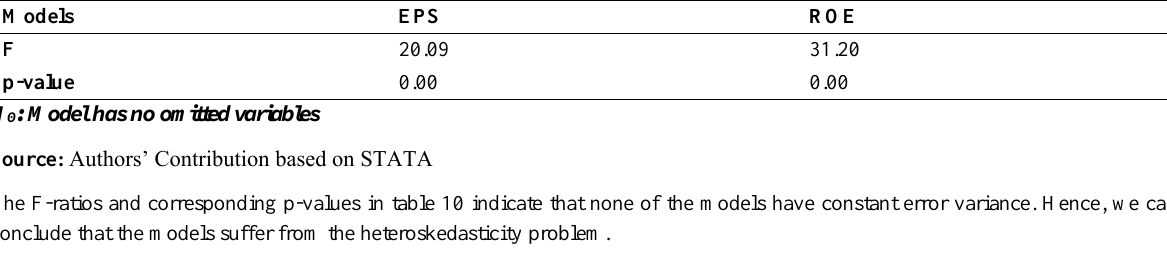
Table-10: Summary of Test for Heteroskedasticity in Pooled OLS